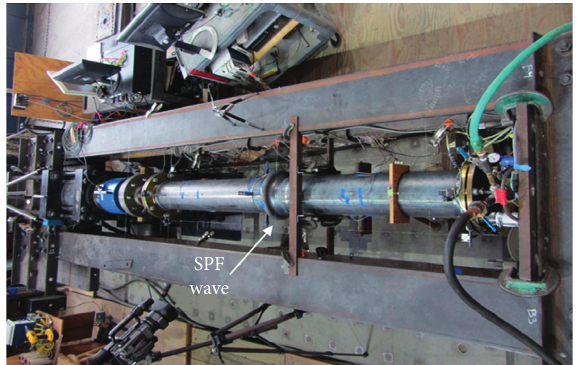
Figure 2: Experimental test of axial compressure of the pipe with waved connection